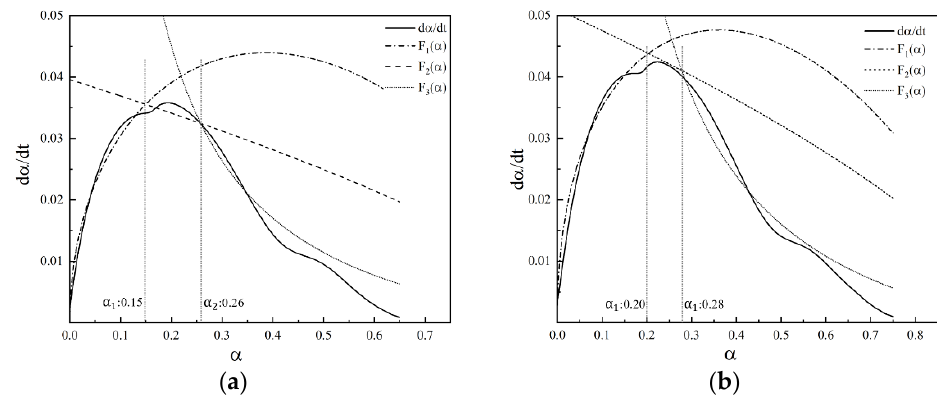
Figure 5. Hydration reaction rate curve of cement mixture with nothing ( a ) and CNA ( b ).